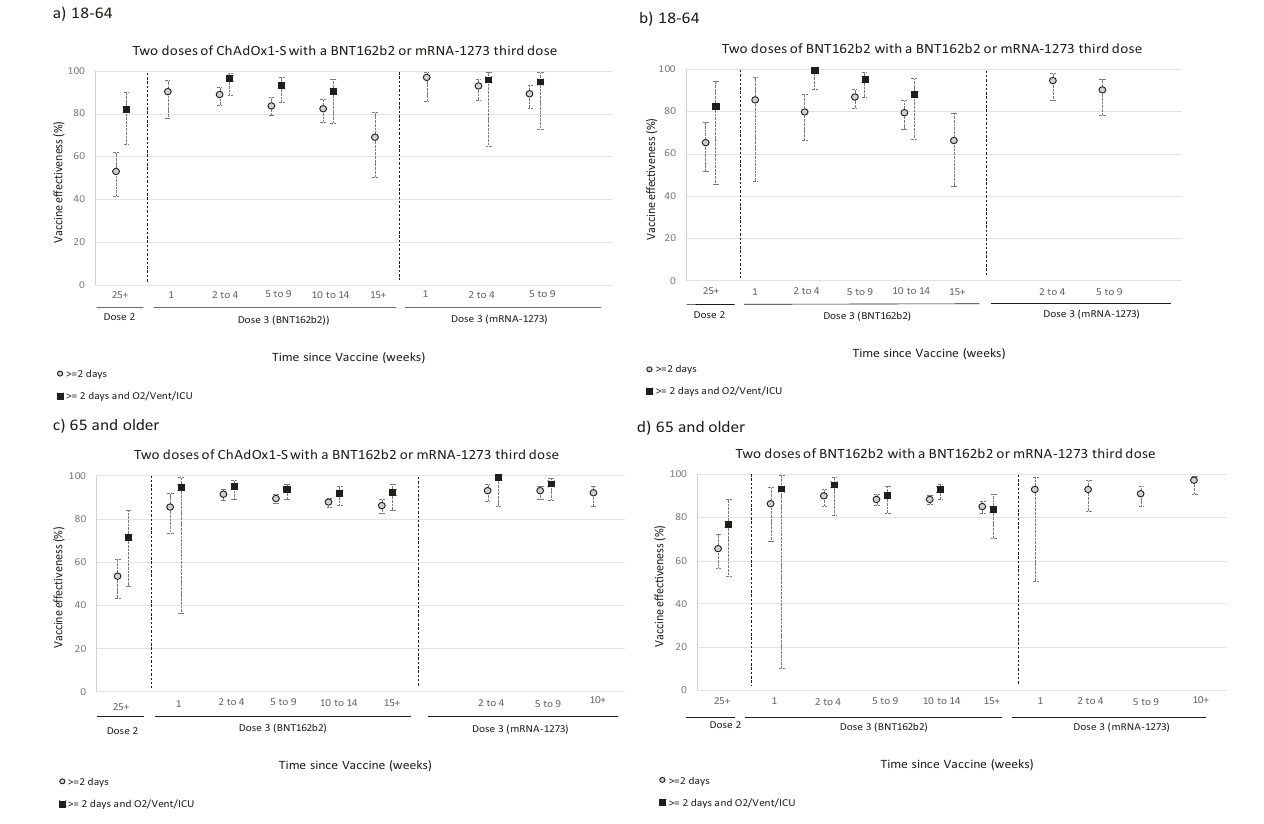
Fig. 3 | Vaccine effectiveness estimates with 95% con fi dence intervals against hospitalisations>=2daysand>=2daysandonoxygen/ventilated/onICUusing SUSbyagegroupandmanufacturer(allsymptomaticcontrols,Omicrononly). Vaccine effectiveness estimates are adjusted using sex, index of multiple depriva- tion (quintile), ethnic group, care home residence status (for age 65+), geographic region (NHS region), period (calendar week of the test), health and social care